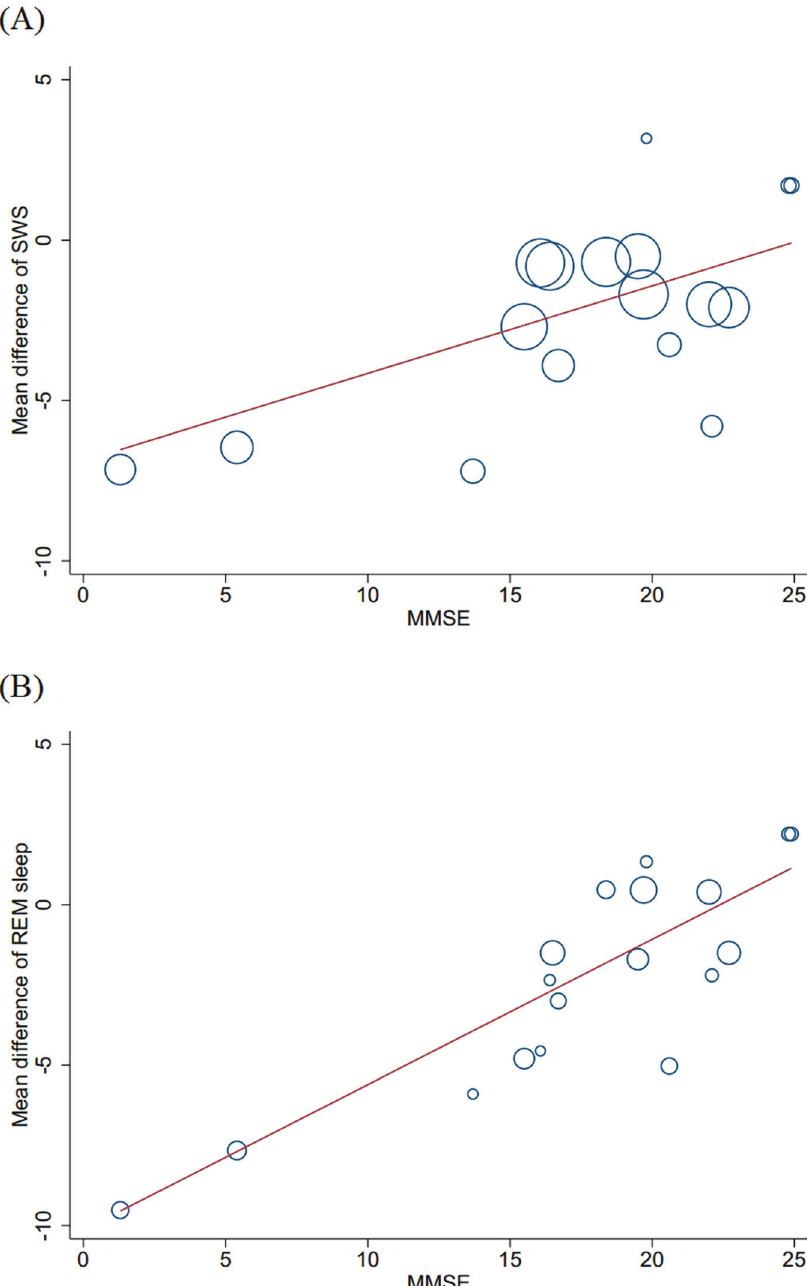
Fig. 2 Signi fi cant associations between sleep changes and MMSE score in patients with Alzheimer ’ s disease. A Associations of the changes in slow wave sleep (coef fi cient = 0.273; p = 0.004) with MMSE score in patients with Alzheimer ’ s disease in studies using R&K criteria; B Associations of the changes in rapid eye movement sleep (coef fi cient = 0.453; p < 0.001) with MMSE score in patients with Alzheimer ’ s disease in studies using R&K criteria. MMSE mini-mental state